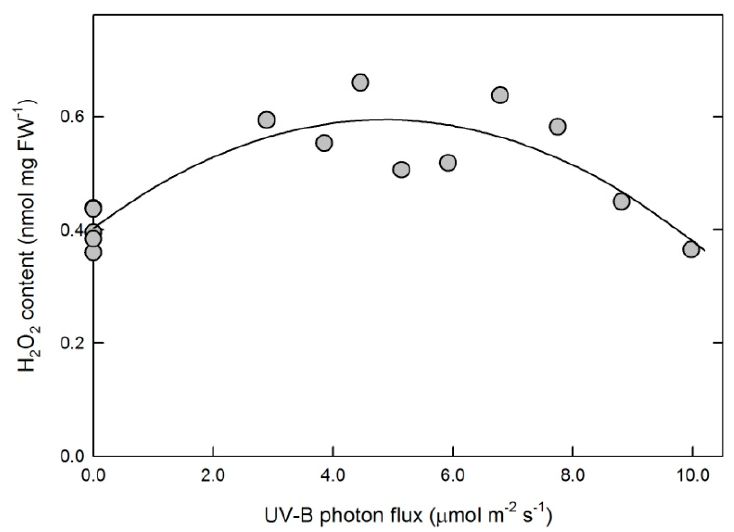
Figure 3. Changes in leaf H 2 O 2 contents in tobacco leaves exposed to various UV-B photon fluxes. Symbols represent data of individual leaves and the solid line shows the result of a second order polynomial fit characterized by p < 0.001.